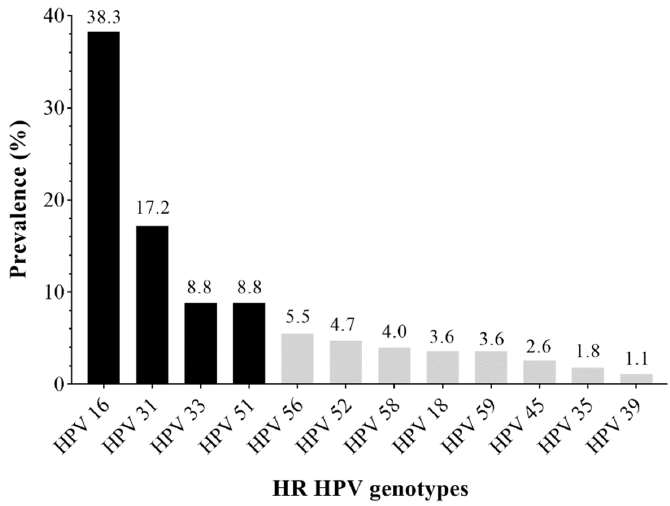
Figure 1. Genotype ‐ specific distribution of HR HPVs. Figure 1. Genotype-specific distribution of HR